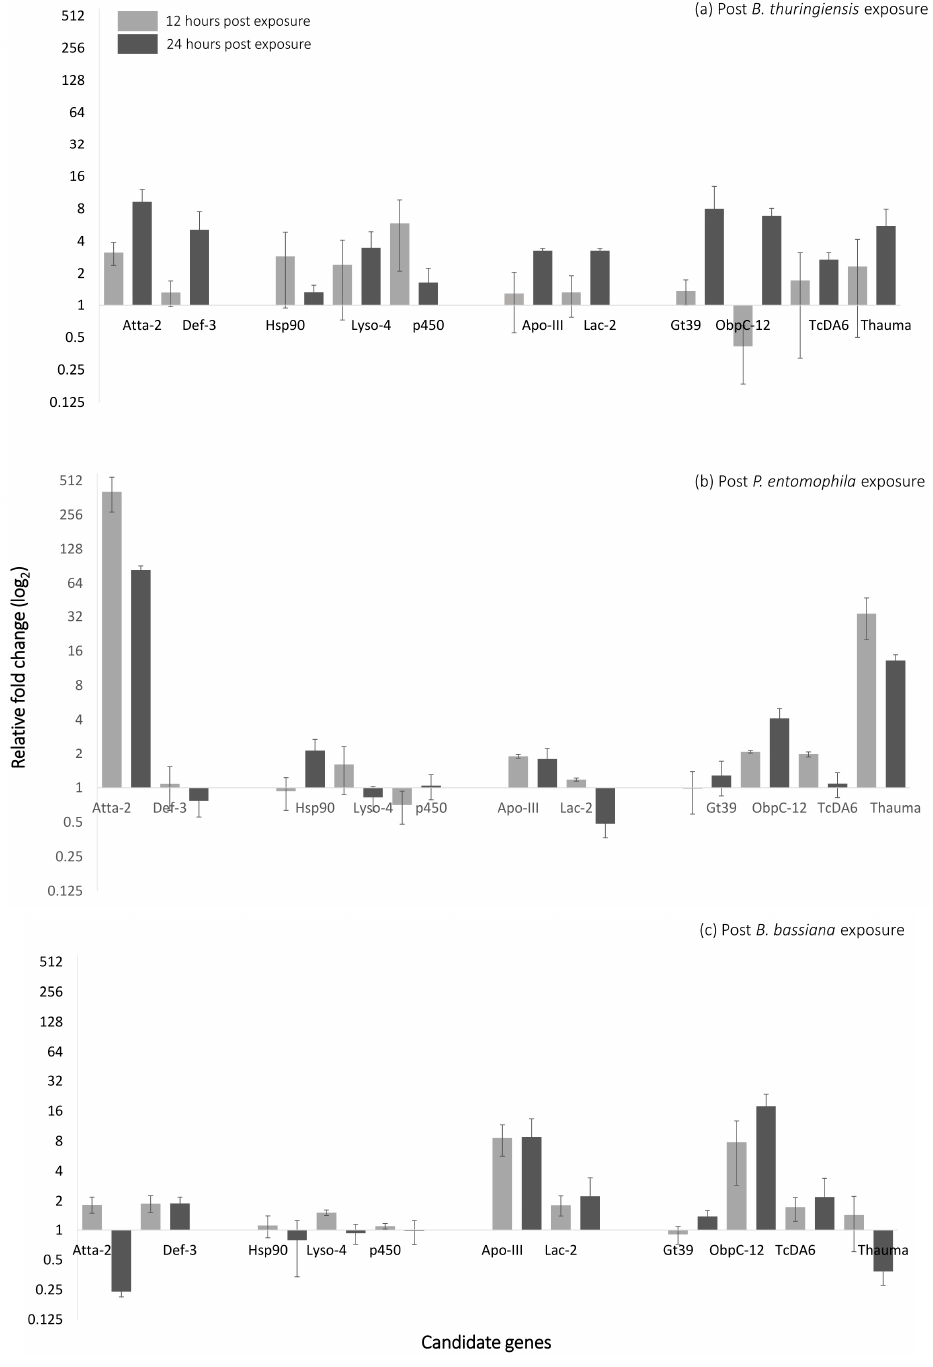
Figure 2. RT-qPCR results on the coevolved beetles (relative to coevolved beetles not exposed to